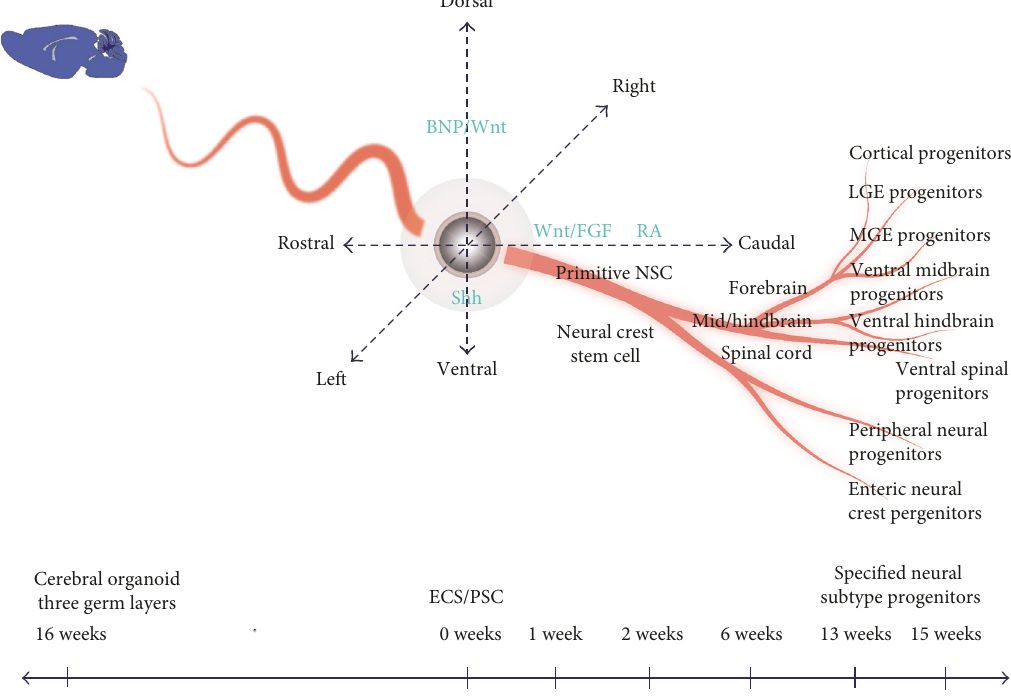
Figure 1: Steered with the speci fi c spatiotemporal control strategies, a single embryonic stem cell (ESC) or pluripotent stem cell (PSC) can develop to a three germ layer brain and pure neural type. The outline has been depicted in Tao ’ s paper (Tao et al.). BNP: bone morphogenetic protein; ESC: embryonic stem cell; FGF: fi broblast growth factor; LGE: lateral ganglionic eminence; MGE: medial ganglionic eminence; NSC: neural stem cell; PSC: pluripotent stem cell; RA: retinoic acid; Shh: sonic